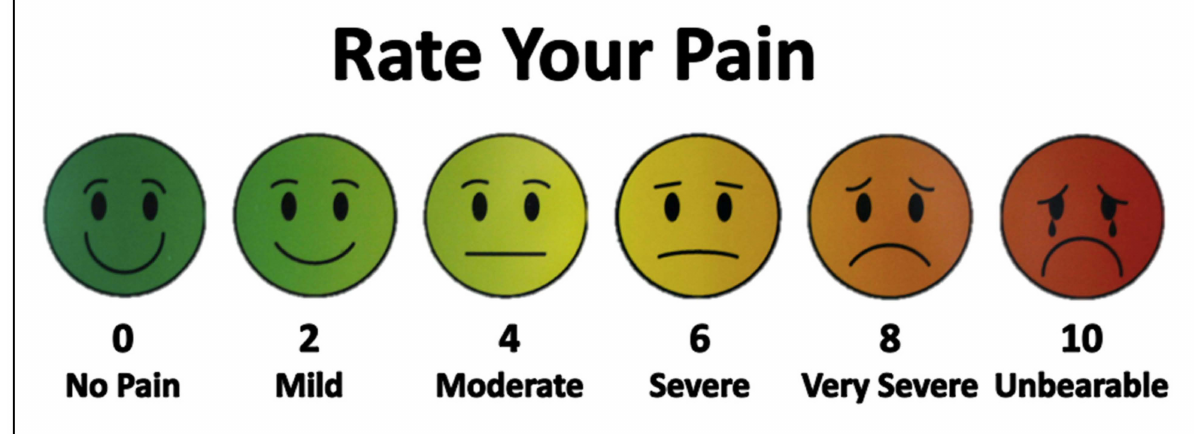
Figure 2. Visual Analog Scale delineating six smile